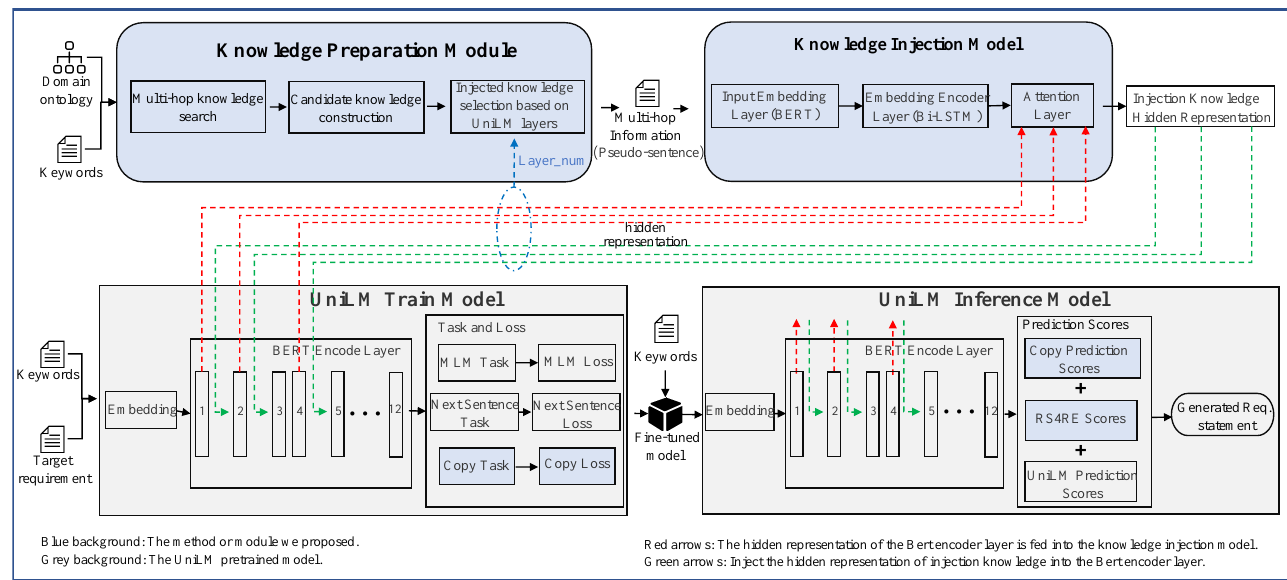
Figure 2. The procedure of our ReqGen